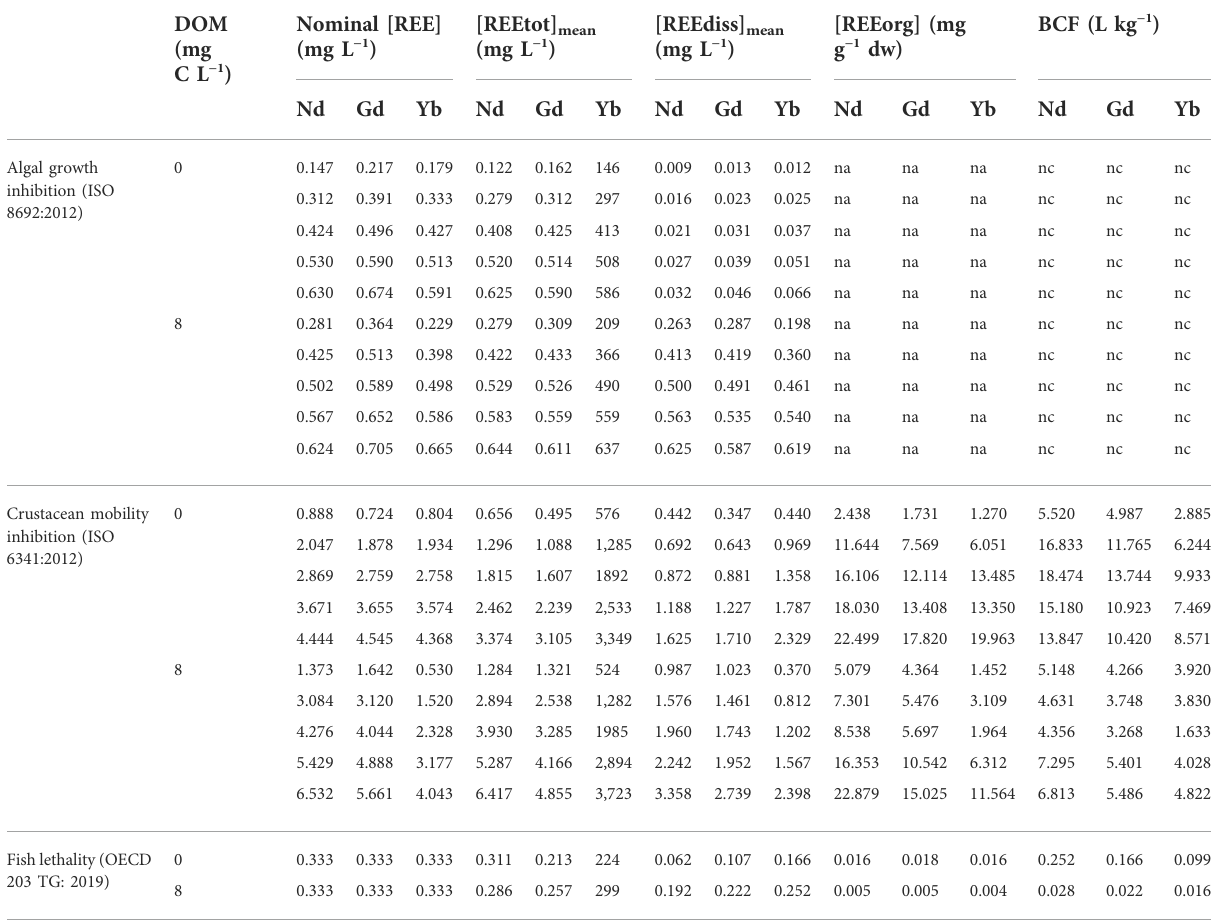
TABLE2ConcentrationsofNd,GdandYbinthemediumandtheorganismsofmixtureexperiments.[REEtot] mean and[REEdiss] mean correspondtothe geometric mean (= √ (C0*C1)) where C0 refers to the nominal concentration at t0 and C1 refers to the total or dissolved concentration measured at t1. [REEorg] corresponds to the mean of REE concentrations measured at t1 in 8 fi shes (in fi sh test) or to the REE concentration measured at t1 in a pool of daphnids ( ≥ 20 daphnids) (in crustacean test). dw = dry weight. BCF = Bioconcentration factor = [REEorg]/[REEdiss] mean . na = non available. nc = not